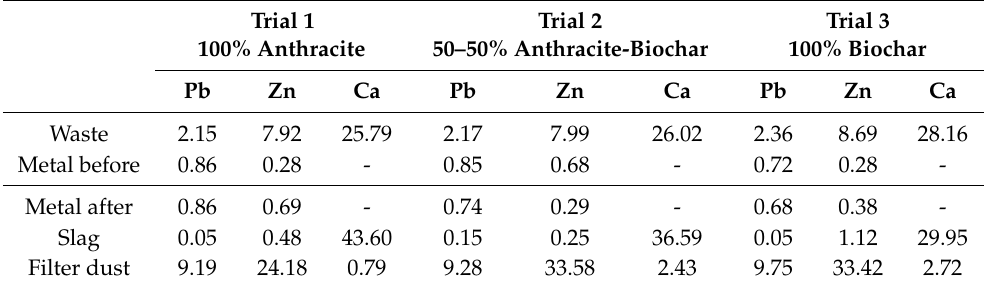
Table 6. Chemical composition of the different streams involved in the metallurgical trials